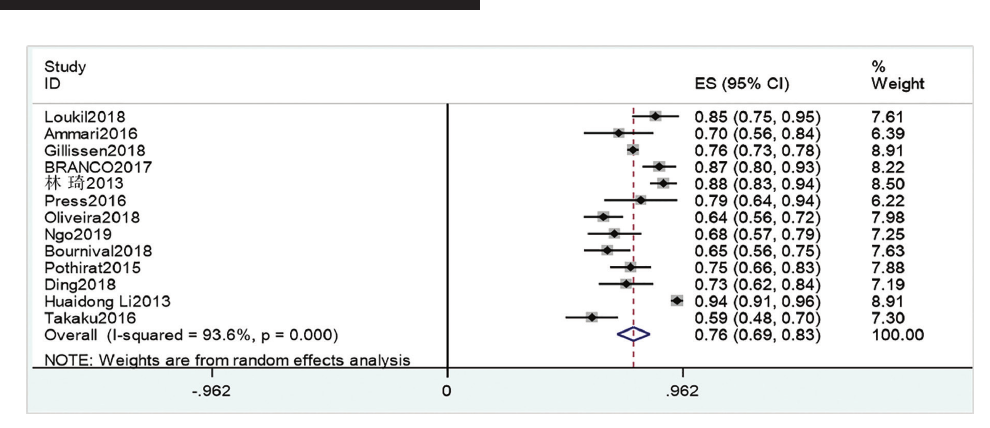
Figure 3. Forest plots of error rates for at least 1 inhaler.